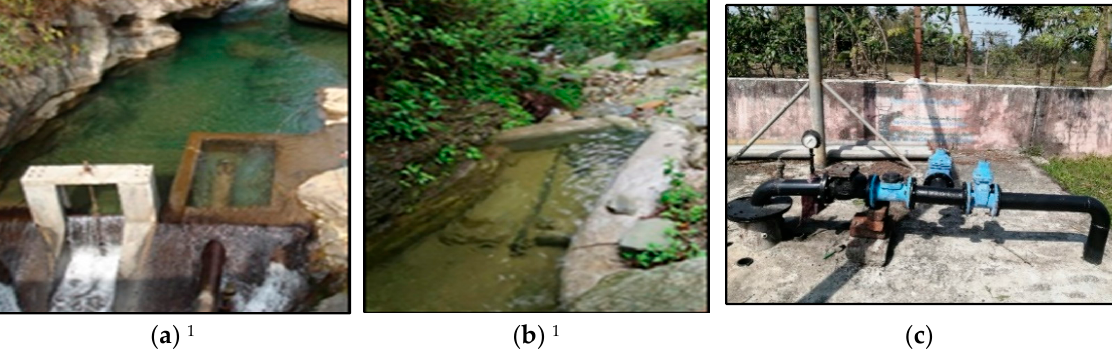
Figure 1. Major water sources in Nepal: ( a ) stream, ( b ) spring, and ( c ) deep tube-well. 1 Source: Lekhnath Small Town Water Supply and Sanitation User Committee (LSTWSSUC).